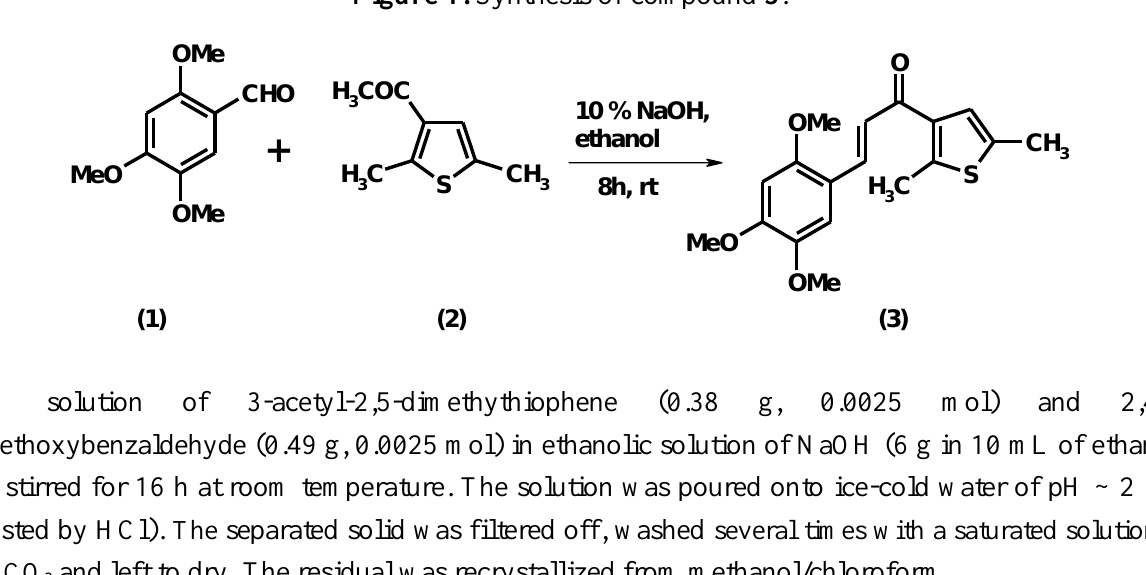
Figure 1. Synthesis of compound 3